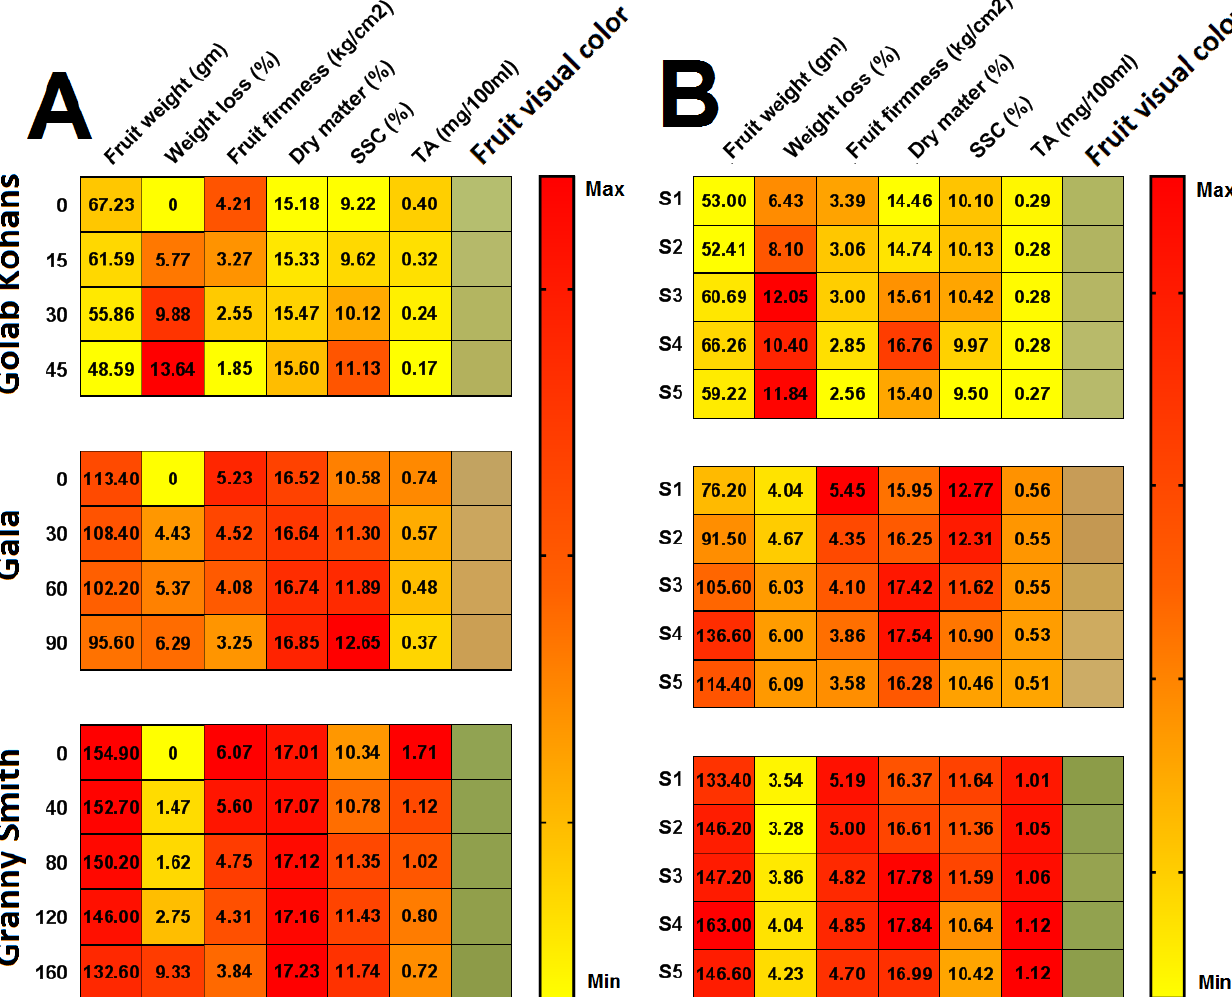
The scale to the right refers to the